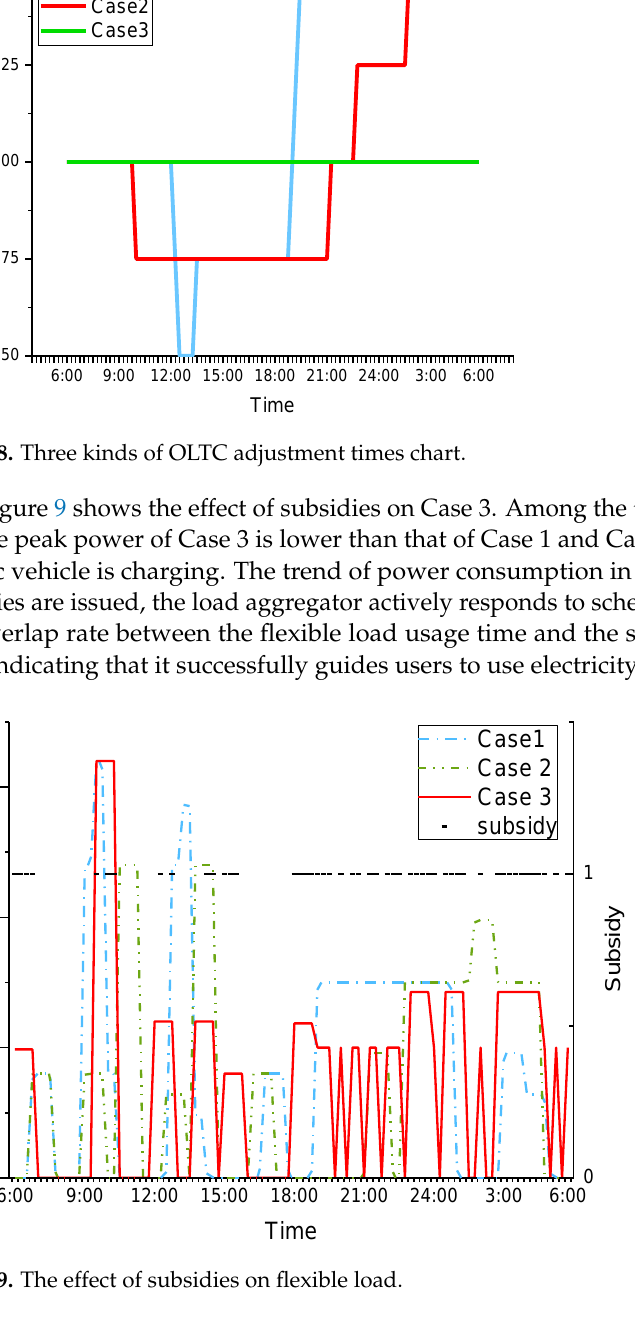
Figure 9. The effect of subsidies on flexible load.